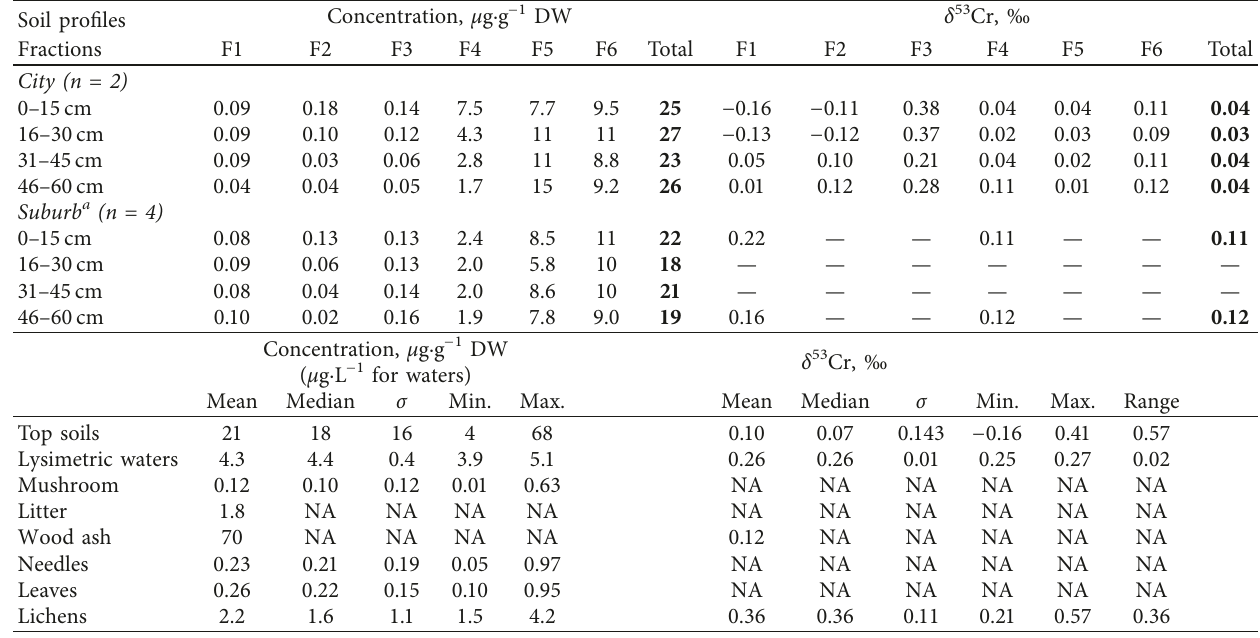
Table 6: Chromium concentrations and isotopic composition in environmental samples from Lule˚a. Soil profiles